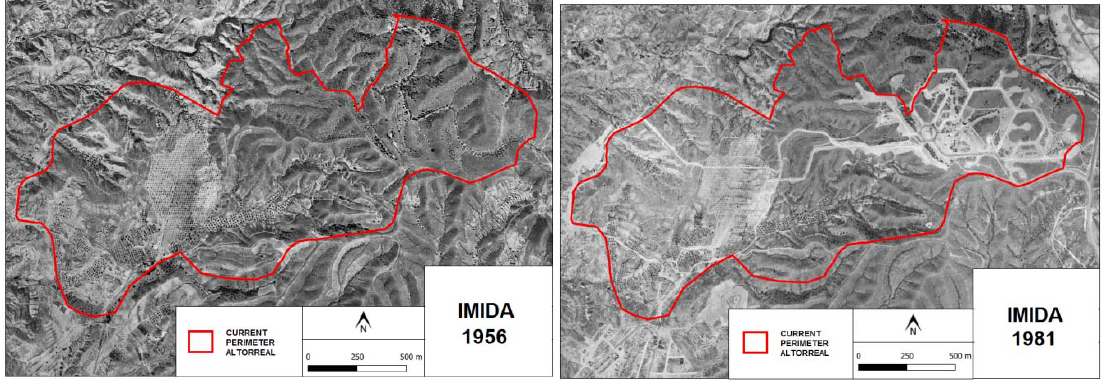
Figure 3. The first constructions in the Altorreal urbanization.